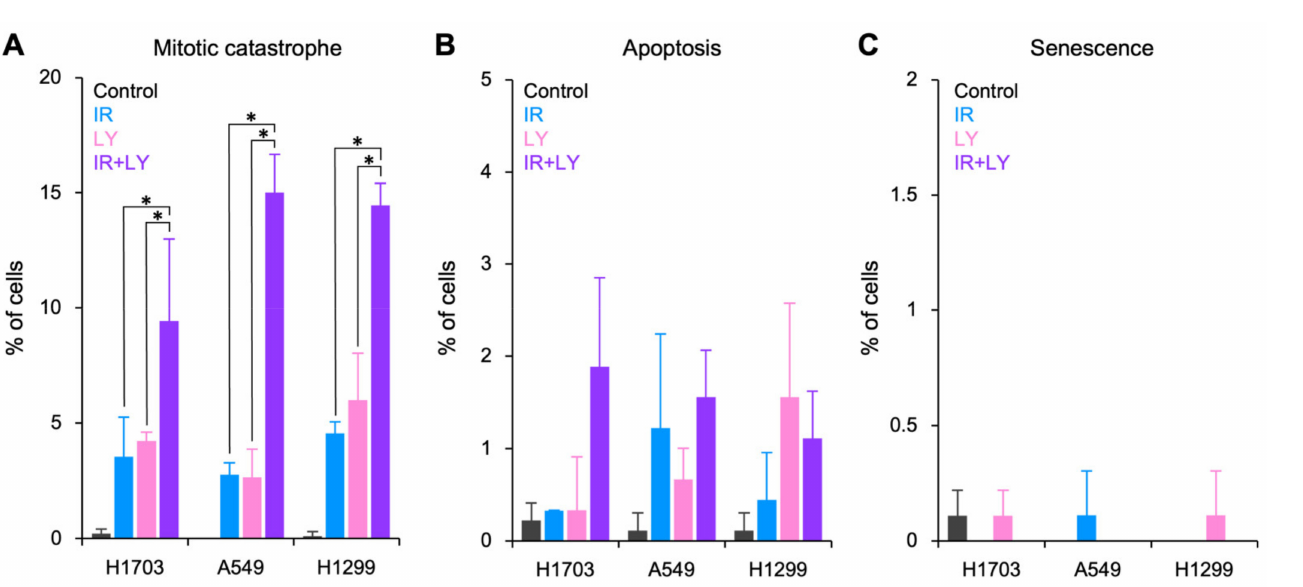
Figure 2. Enhancement of radiation-induced cell death by LY2874455. ( A ) Mitotic catastrophe. ( B ) Apoptosis. ( C ) Senescence. Cells were treated with X-rays (4 Gy) and/or LY2874455 (100 nM) from 1 h pre-irradiation until staining with DAPI 72 h later (mean ± s.d., n = 3, 300 cells